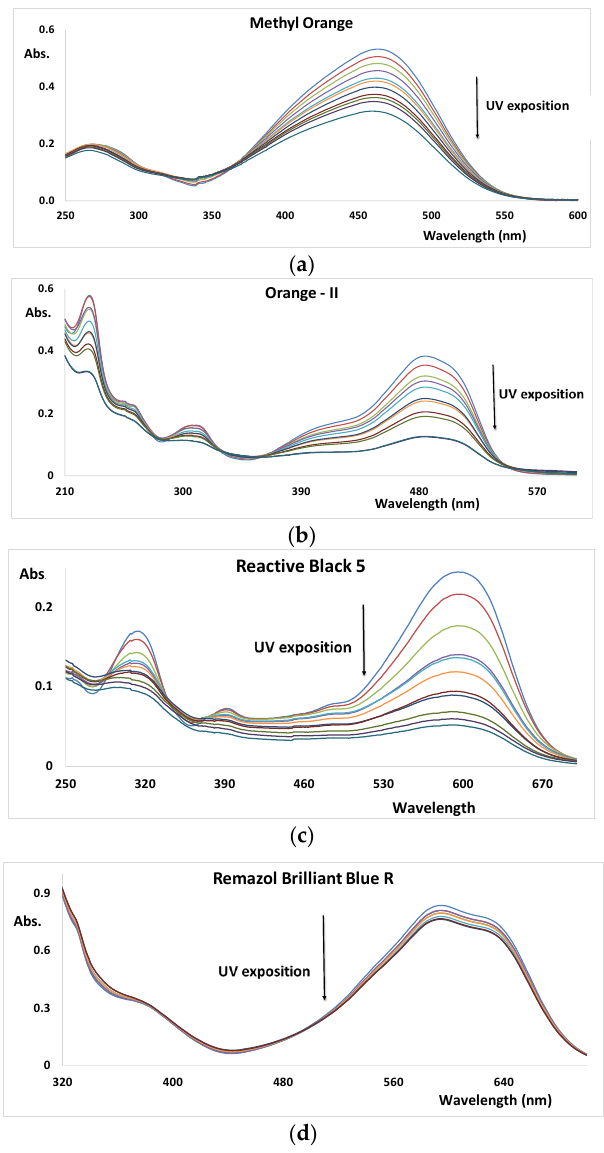
Figure 2. UV–Vis spectra of dyes as function of the UV exposition (pH = 10, and reaction time = 30 min). ( a ) Methyl orange; ( b ) Orange-II; ( c ) Reactive Black 5; and ( d ) Remazol Brilliant Blue R. Table 1. Apparent rate constant and percentage of dye removal (at 30 min) of the UV AOP of dyes (the standard deviations of at least three independent repetitions are shown). The fitting of the in- tegrated first-order kinetics resulted in R 2 > 0.98.